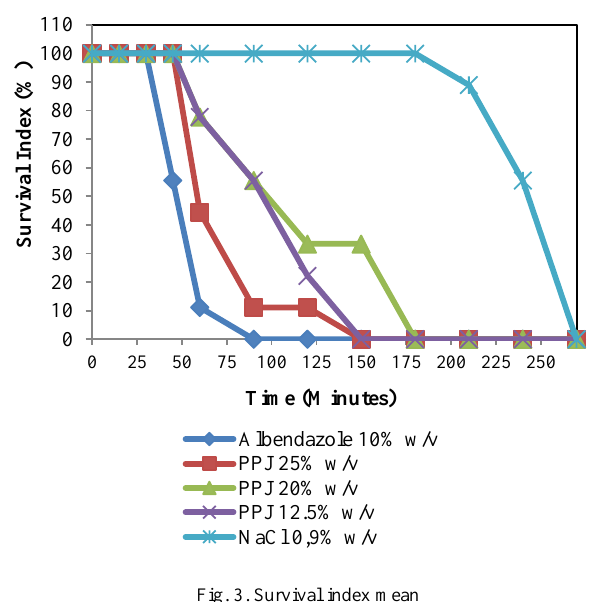
Fig. 3. Survival index